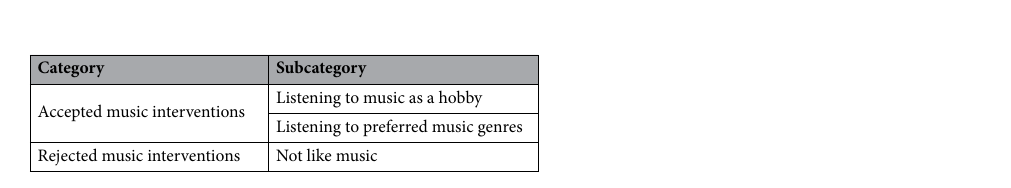
Table 6. Acceptance of music